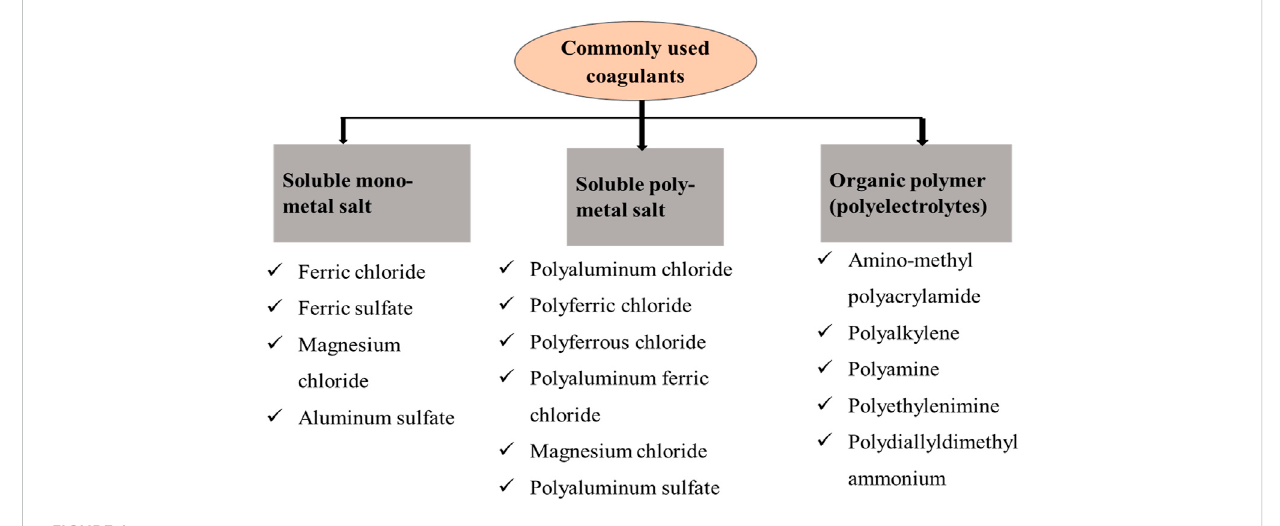
FIGURE 1 Categorization of chemical coagulants according to their